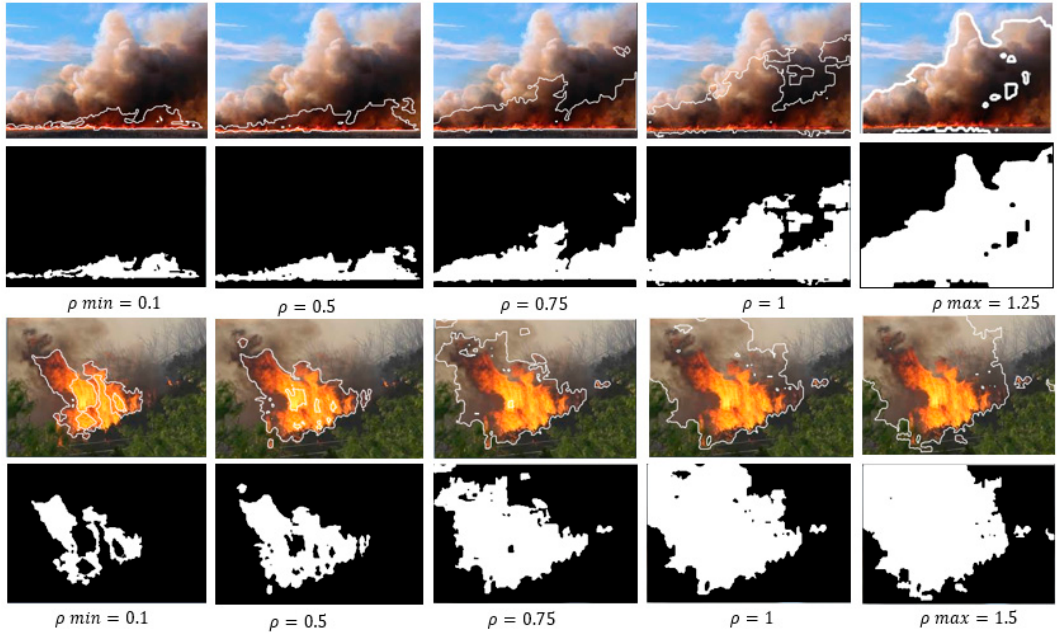
Figure 4. Influence of ρ in detection of flame and surrounding smoke.